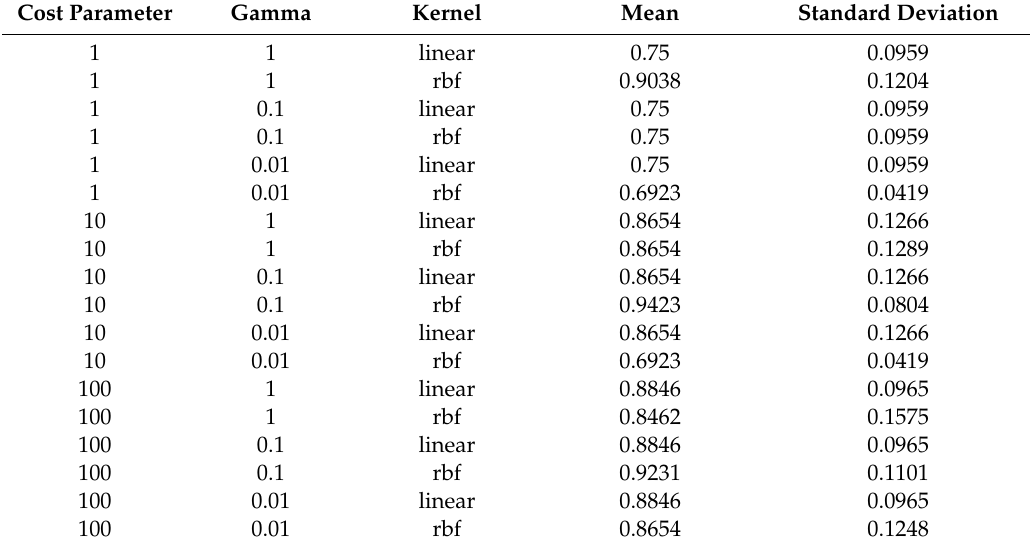
Table 6. Accuracy score and standard deviation of each feature for the combination of fruit battery and computer vision